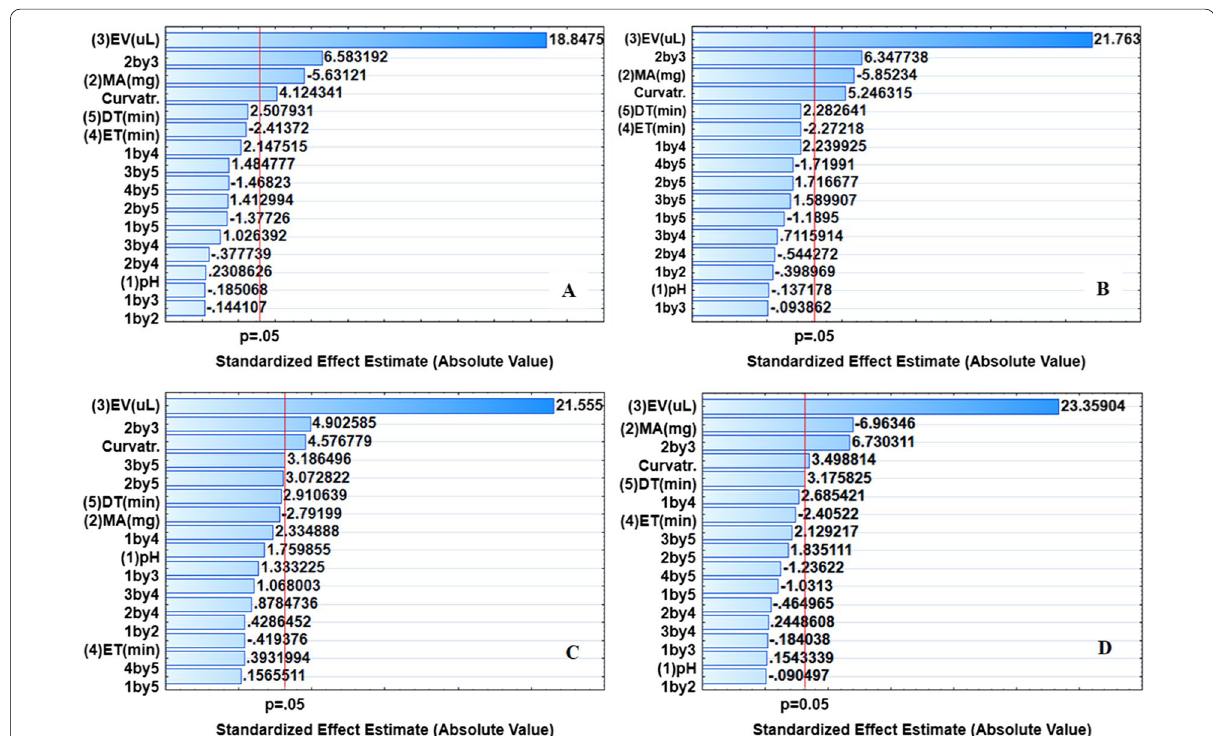
Fig. 6 Pareto charts indicating the effect of factors on extraction and preconcentration of a acetamiprid (ACT), b imidacloprid (IMD), c thiacloprid (TCL) and d clothianidin (CLD) using magnetic-based PABA activated carbon adsorbent. ET extraction time, MA mass of adsorbent, EV eluent volume (EV) and DT desorption time. 1by2: interaction between pH and MA; 1by3: interaction between pH and EV; 1by4: interaction between pH and ET; 1by5: interaction between pH and DT; 2by3: interaction between MA and EV; 2by4: interaction between MA and ET; 2by5: interaction between MA and DT; 3by4: interaction between EV and ET; 3by5: interaction between EV and DT; 4by5: interaction between ET and